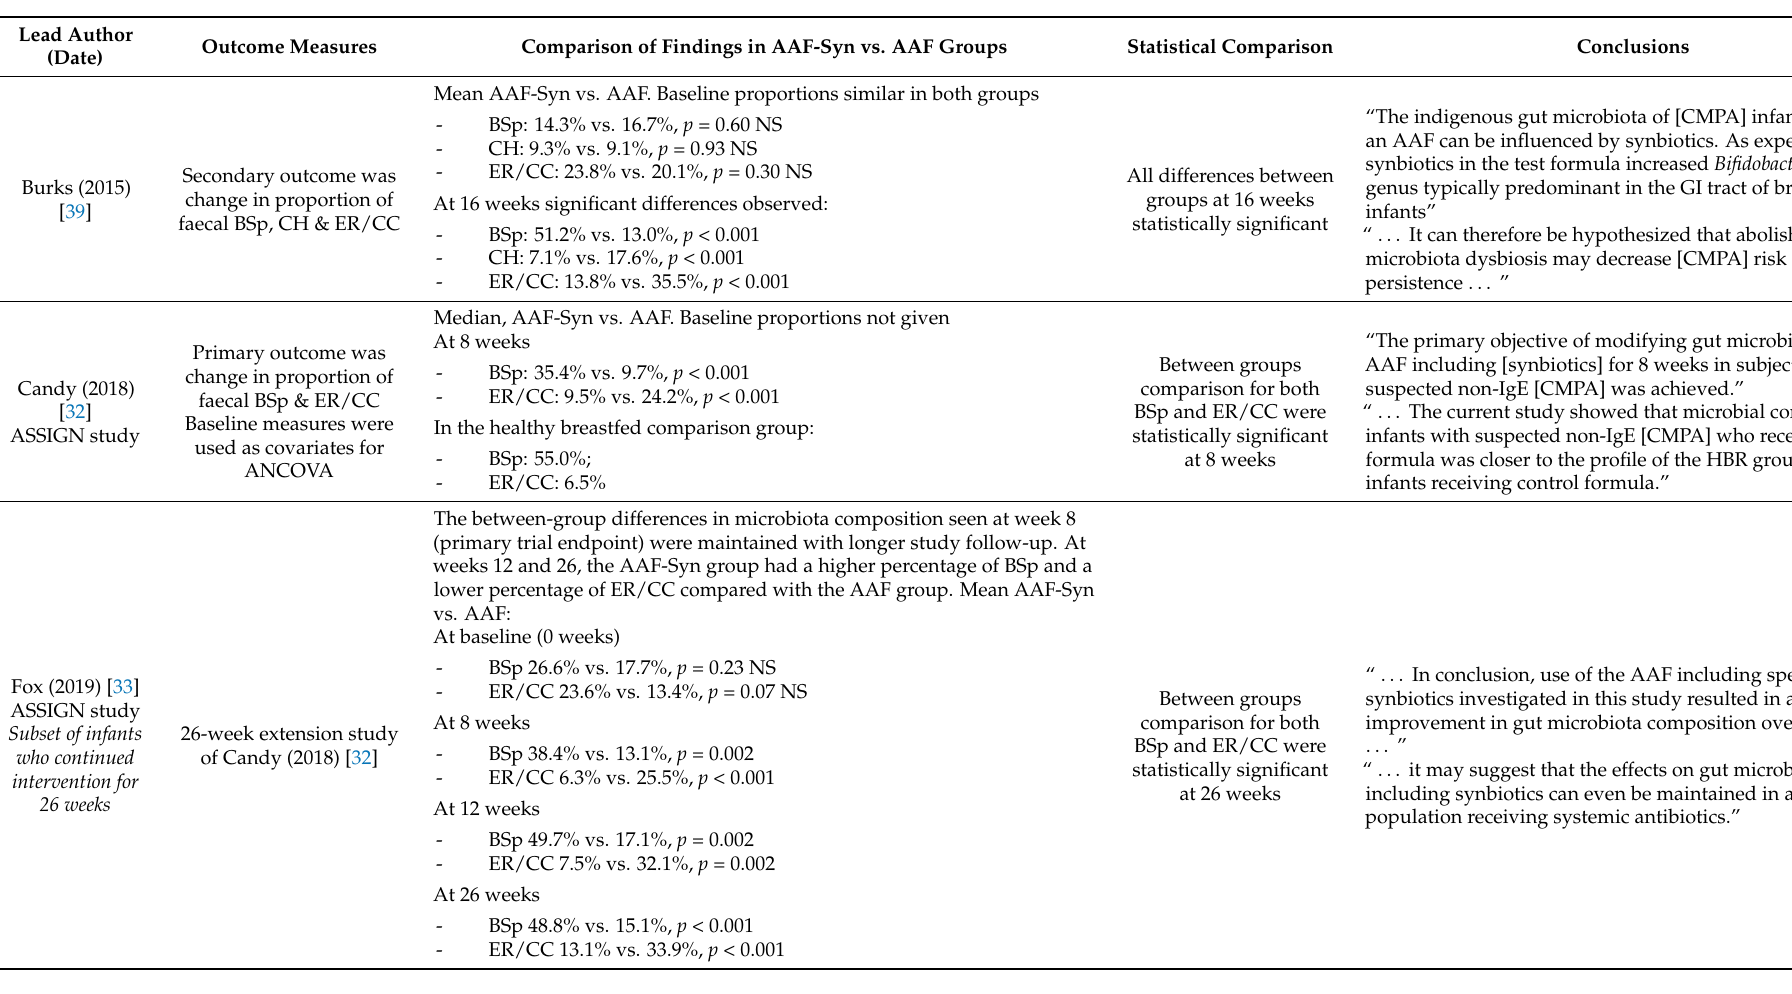
Table 5. Individual publication results of changes in faecal microbiota profile among infants receiving AAF-Syn vs.